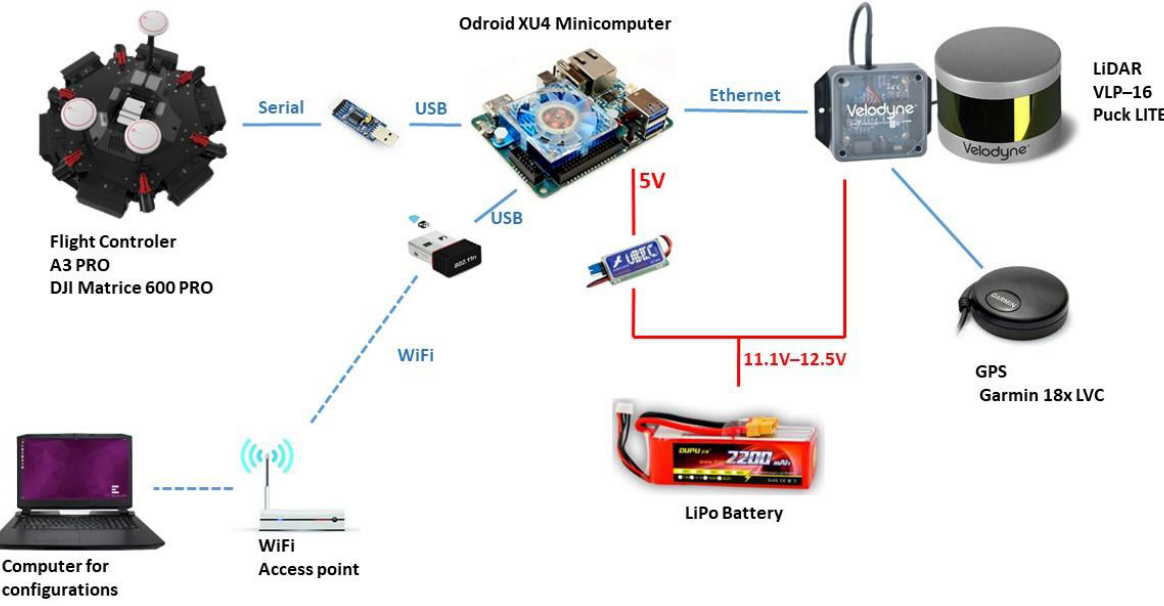
Figure 1. Integration scheme developed for the LiDAR system.